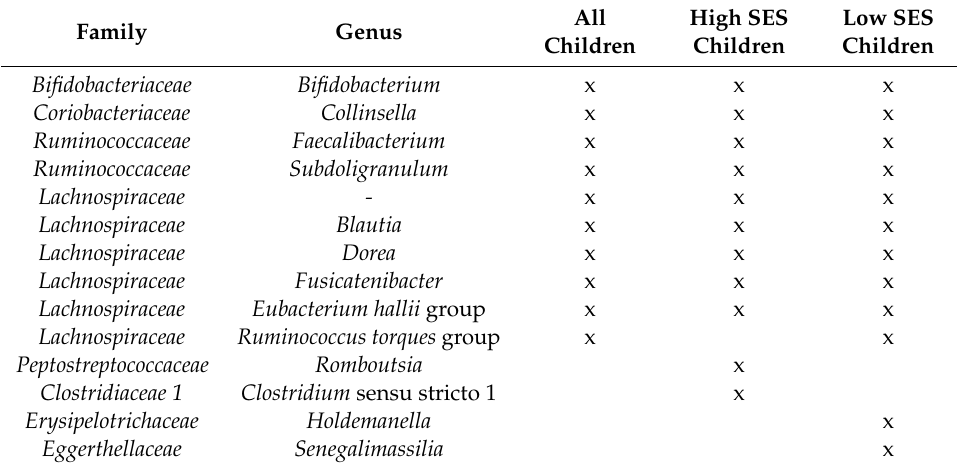
Table 2. Core microbiota in all, high SES, and low SES children.